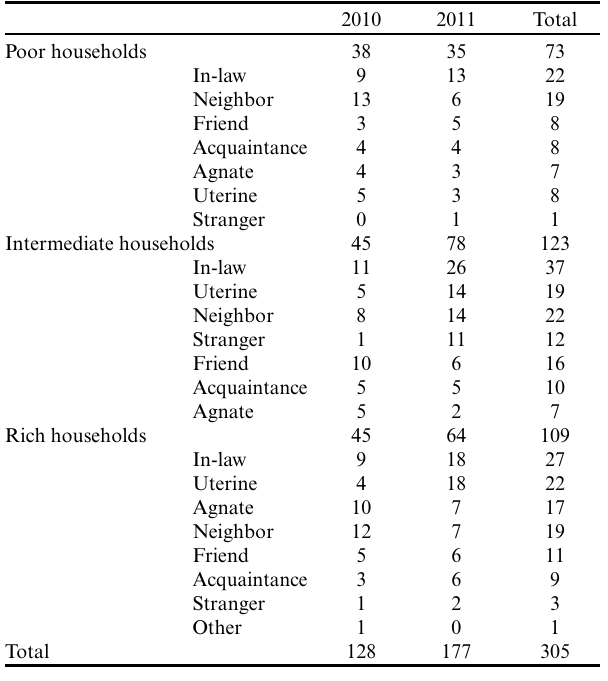
Table 4 . Seed acquisition events according to household economic status and social relationships for 2010 and